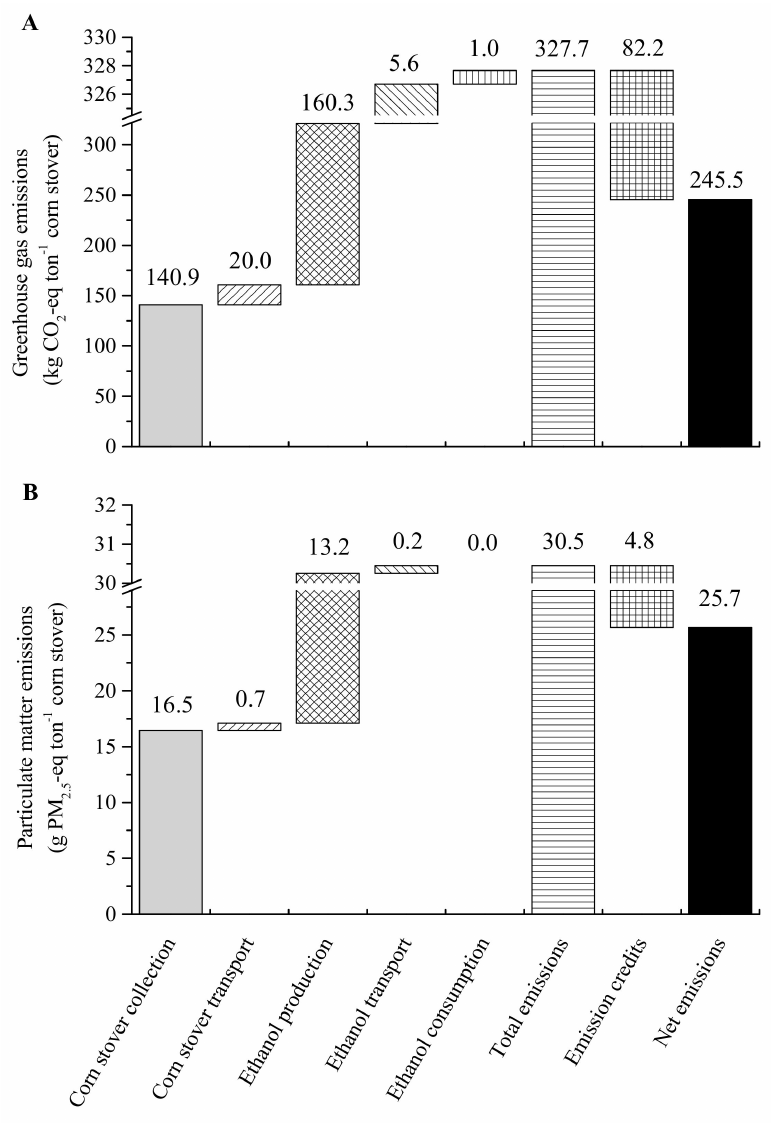
Figure 3. Emissions of greenhouse gas ( A ) and PM 2.5 ( B ) from corn stover based ethanol production by stages (Corn stover collection included corn planting and corn stover collection in